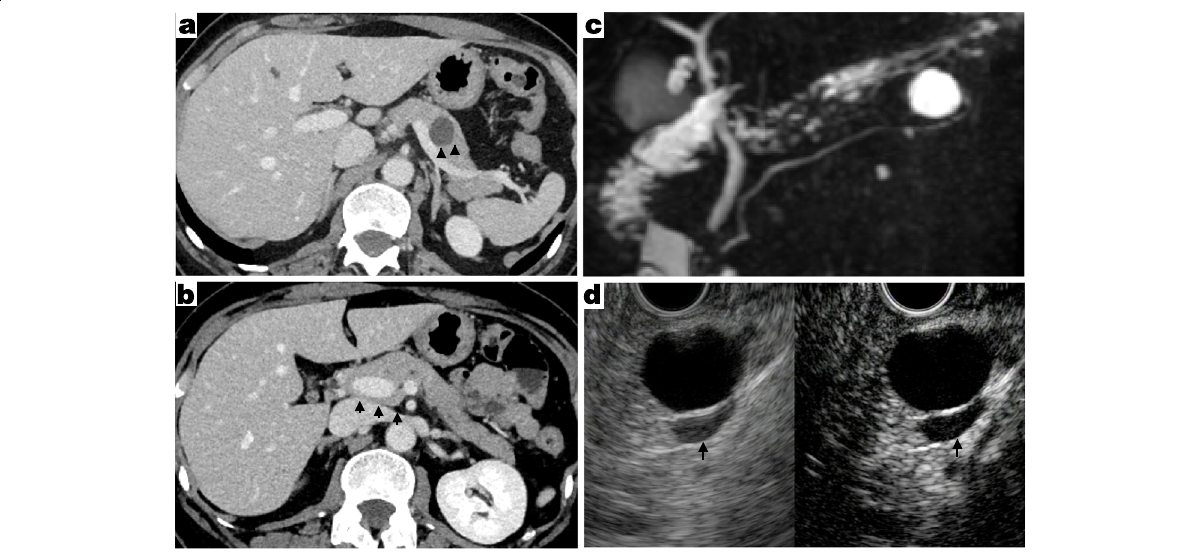
Fig. 1 Preoperative imaging studies. Dynamic computed tomography scan showed oval cystic lesion of 1.5 cm in diameter of the pancreatic tail ( a : arrow head) and portal annular pancreas ( b : arrow). c Magnetic resonance cholangiopancreatography demonstrated the anteportal main pancreatic duct type. d Contrast-enhanced endoscopic ultrasound revealed oval cystic lesion without enhancement